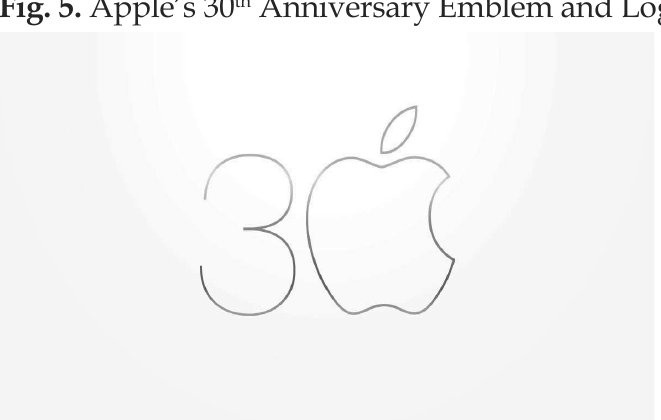
Fig. 5. Apple’s 30 th Anniversary Emblem and